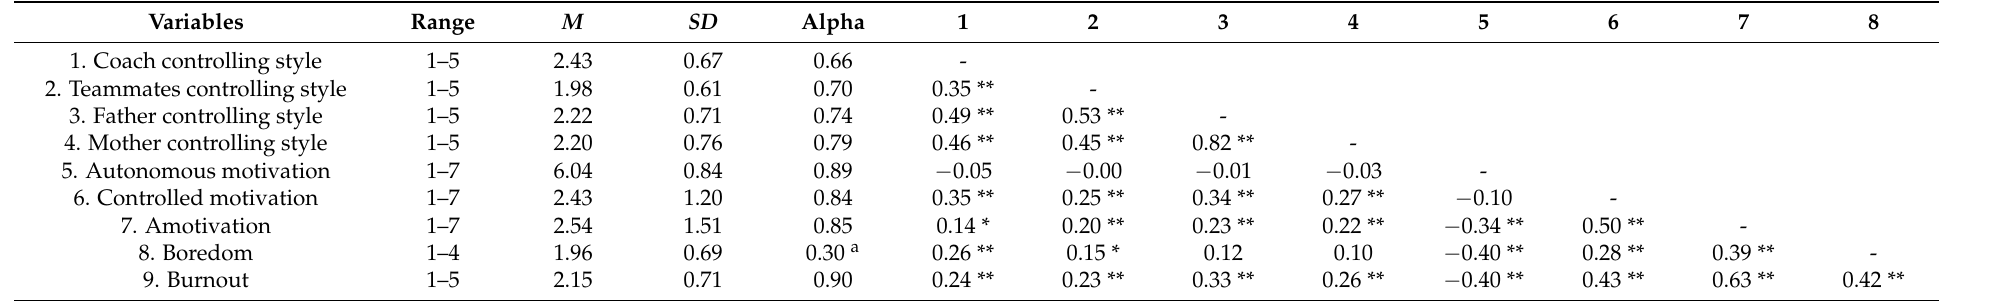
Table 1. Descriptive statistics, reliabilities, and correlations between study